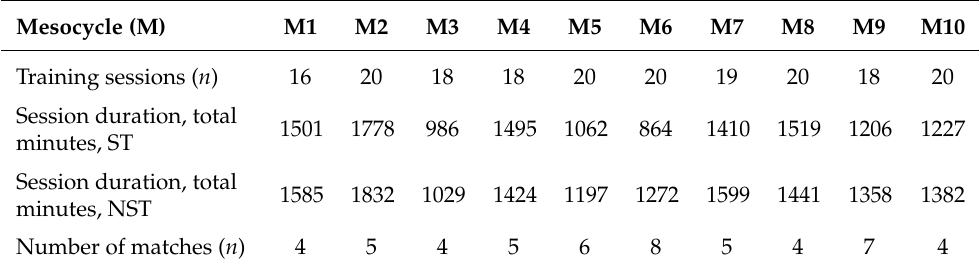
Table 1. Training sessions and number of competitive matches during the 41-week period. Mesocycle